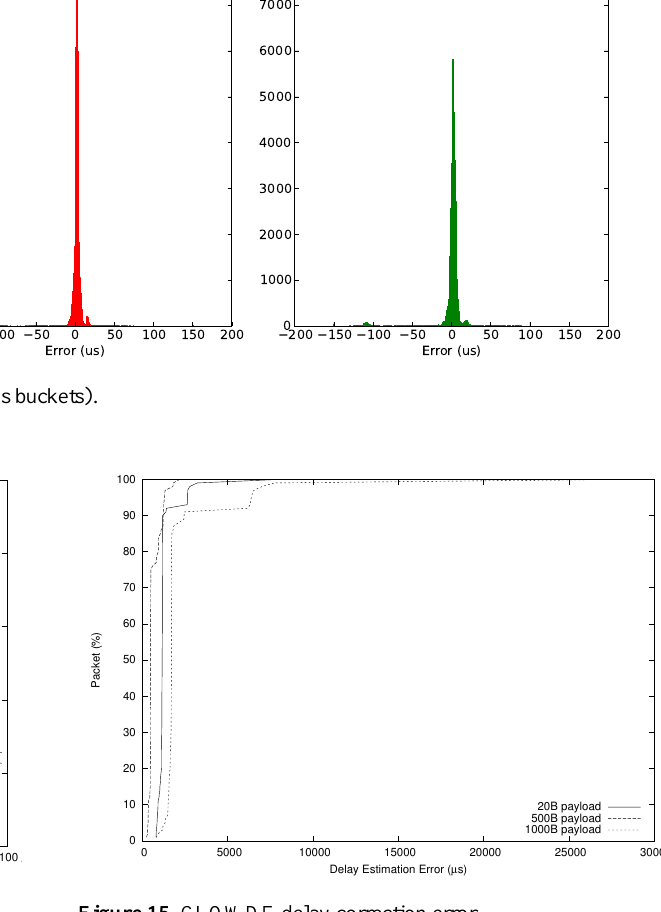
Fig. 13: Histogram of difference between clock sources (1us buckets)